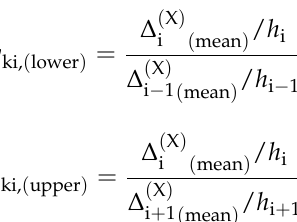
ki ) of RC building